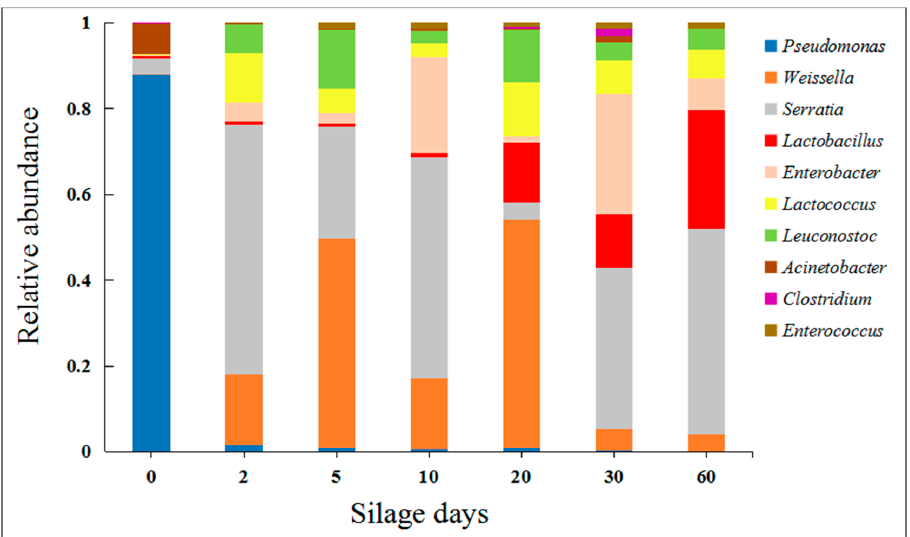
Figure 2. The relative abundance of bacteria communities at the genus level in silage. The abscissa stands for the silage time (on day 0, 2, 5, 10, 20, 30, and 60) and the ordinate stands for the relative abundance of each bacterial community at the genus level.